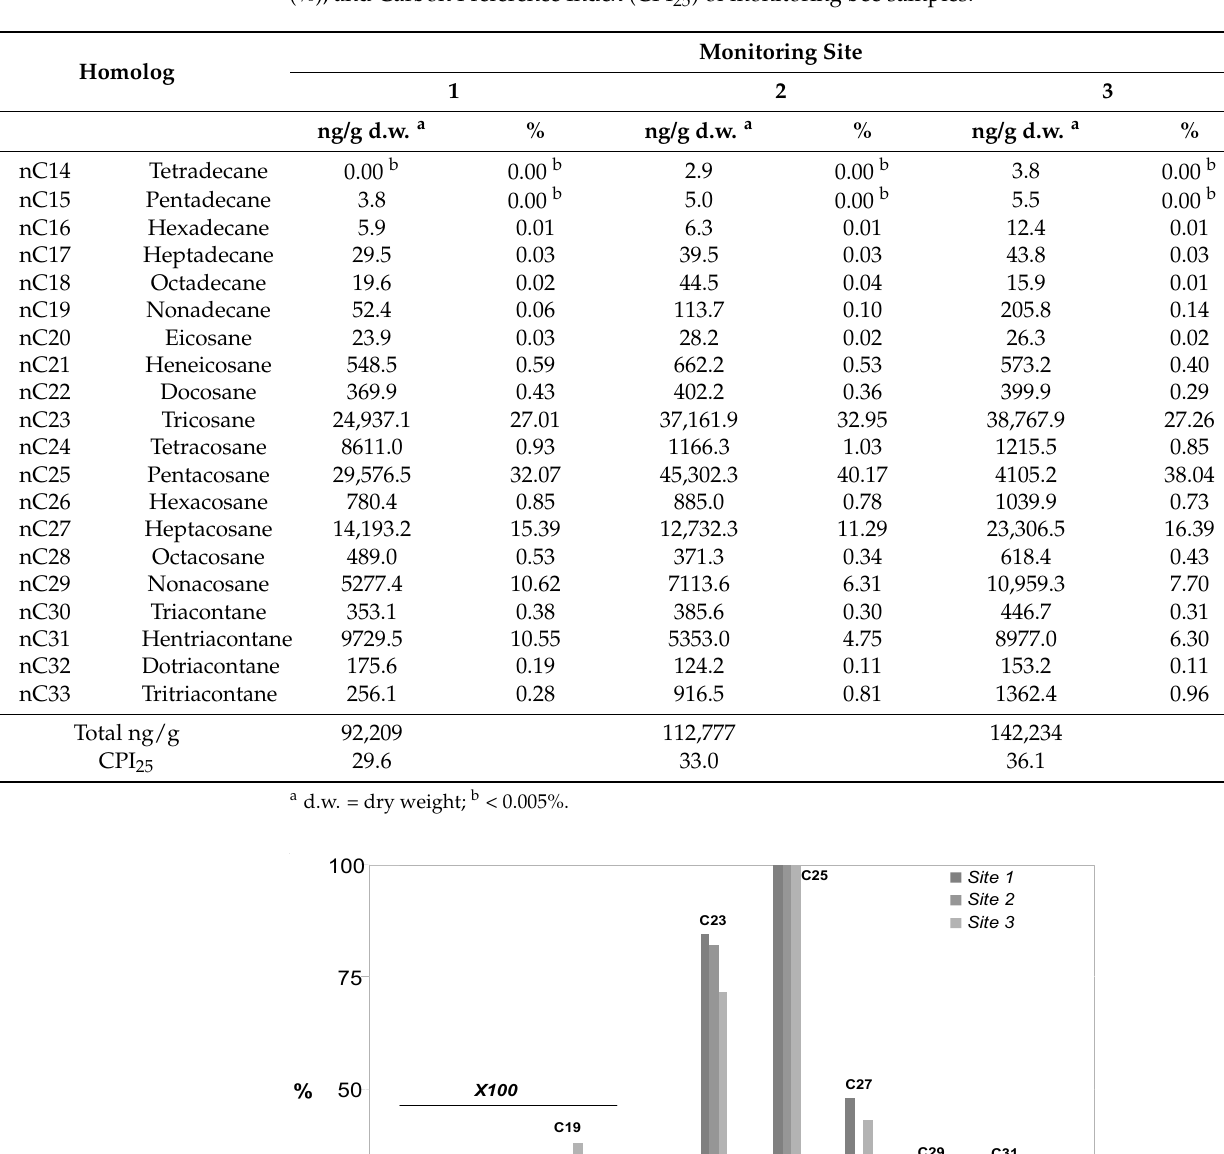
Table 1. n-Alkane concentrations (expressed as ng/g honeybee d.w.), relative percent contributions (%), and Carbon Preference Index (CPI 25 ) of monitoring bee samples.